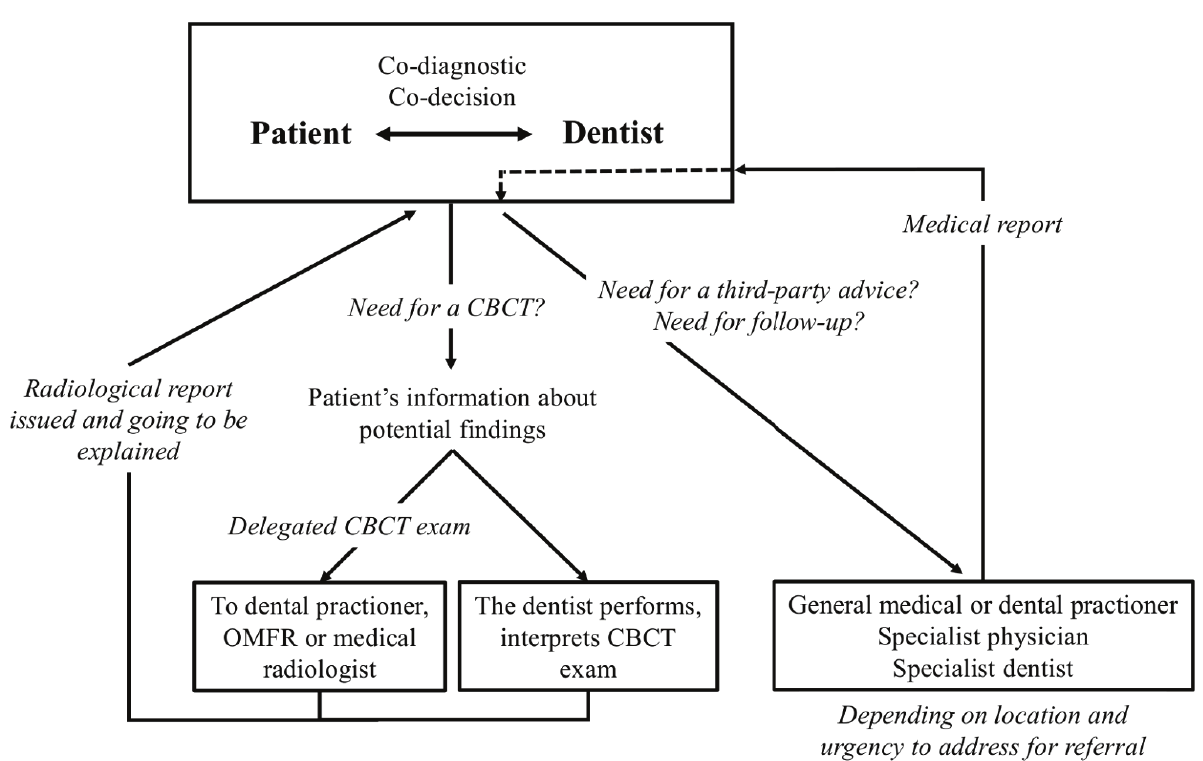
Figure 3: A general framework for the CBCT in oral medicine according to patient-centered care principles. The model highlights the need for shared decision making between the patient and dentist. The patient should be an integral part of care pathway, from acceptance of the possibility of incidental discovery before the CBCT exam to its management and